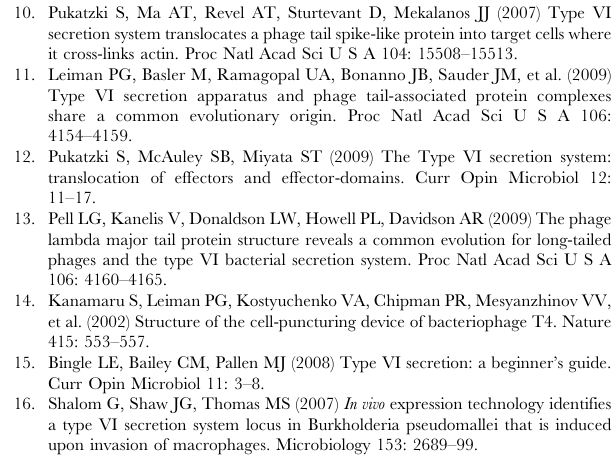
Figure S5 Representation of TssJ conserved residues. TssJ is shown in ribbon representation and rainbow coloring from